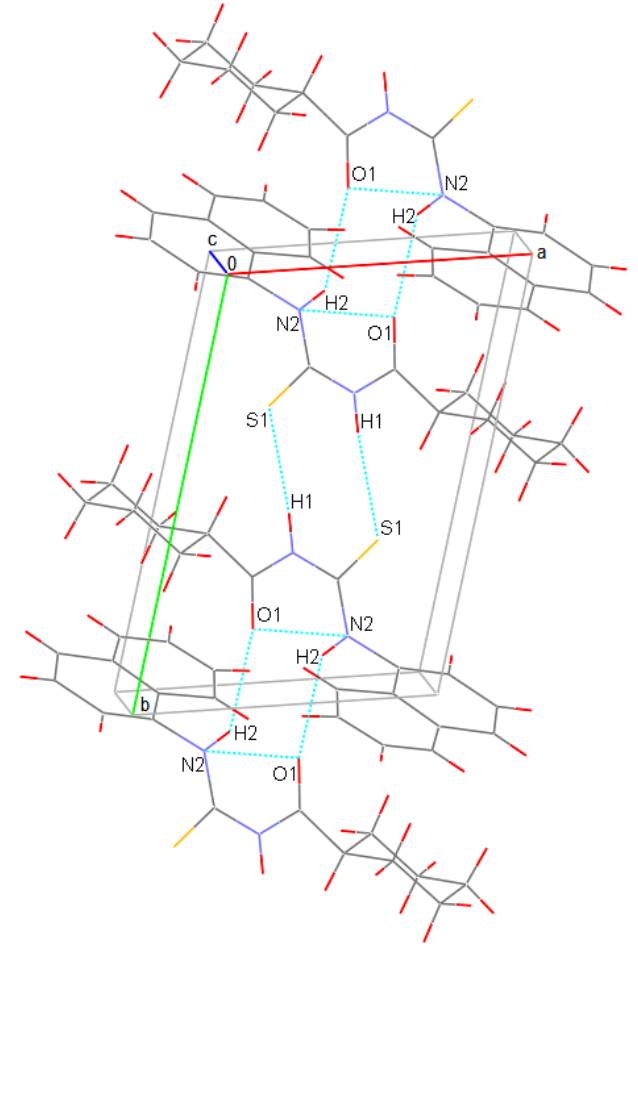
L 9 with hydrogen bonds as dotted lines 2